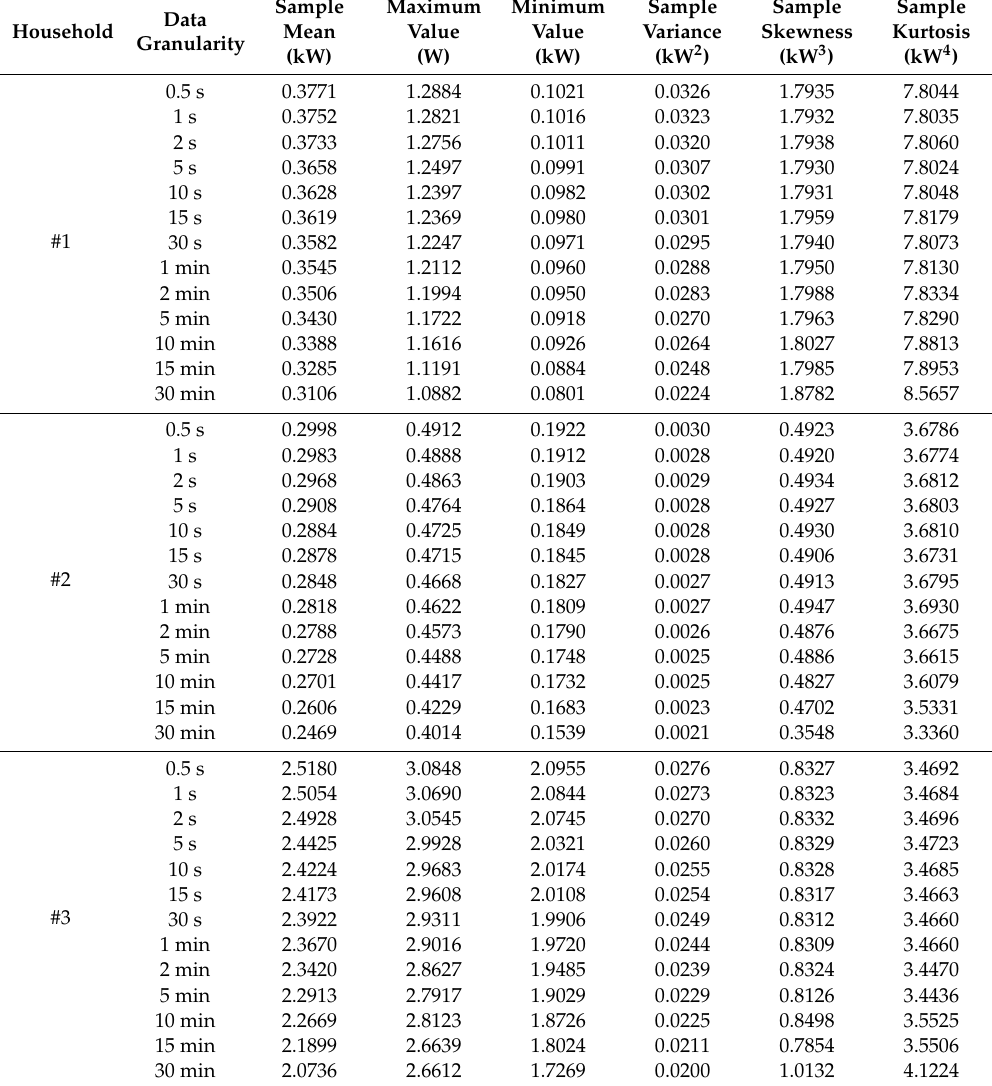
Table 5. Descriptive statistics of the consumption load profile throughout the